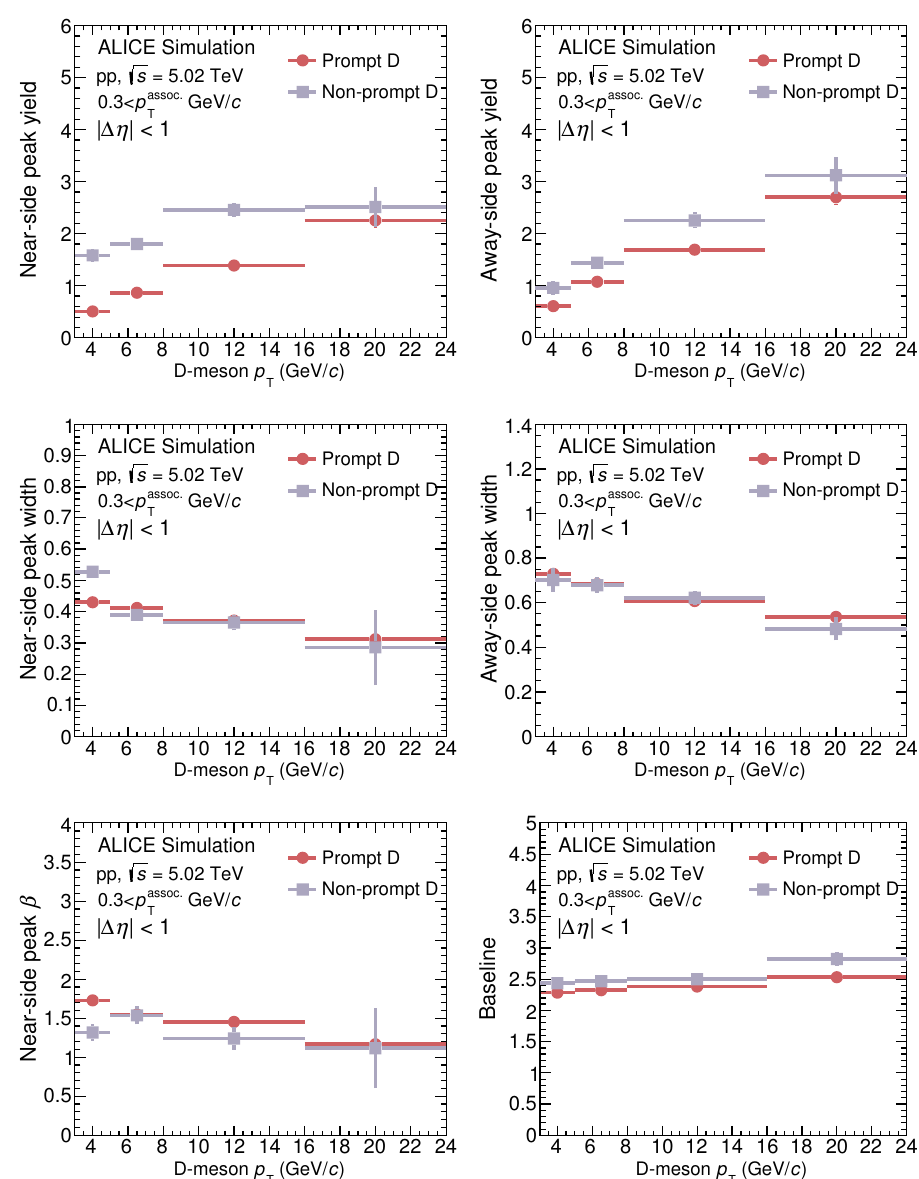
Figure 5. Near- and away-side peak yield ( top row ), width ( middle row ), β parameter and base- line ( bottom row ) of prompt and non-prompt D meson correlations with hadrons in simulated √ s = 5.02 TeV as a function of the D meson p T for p assoc. pp collisions at